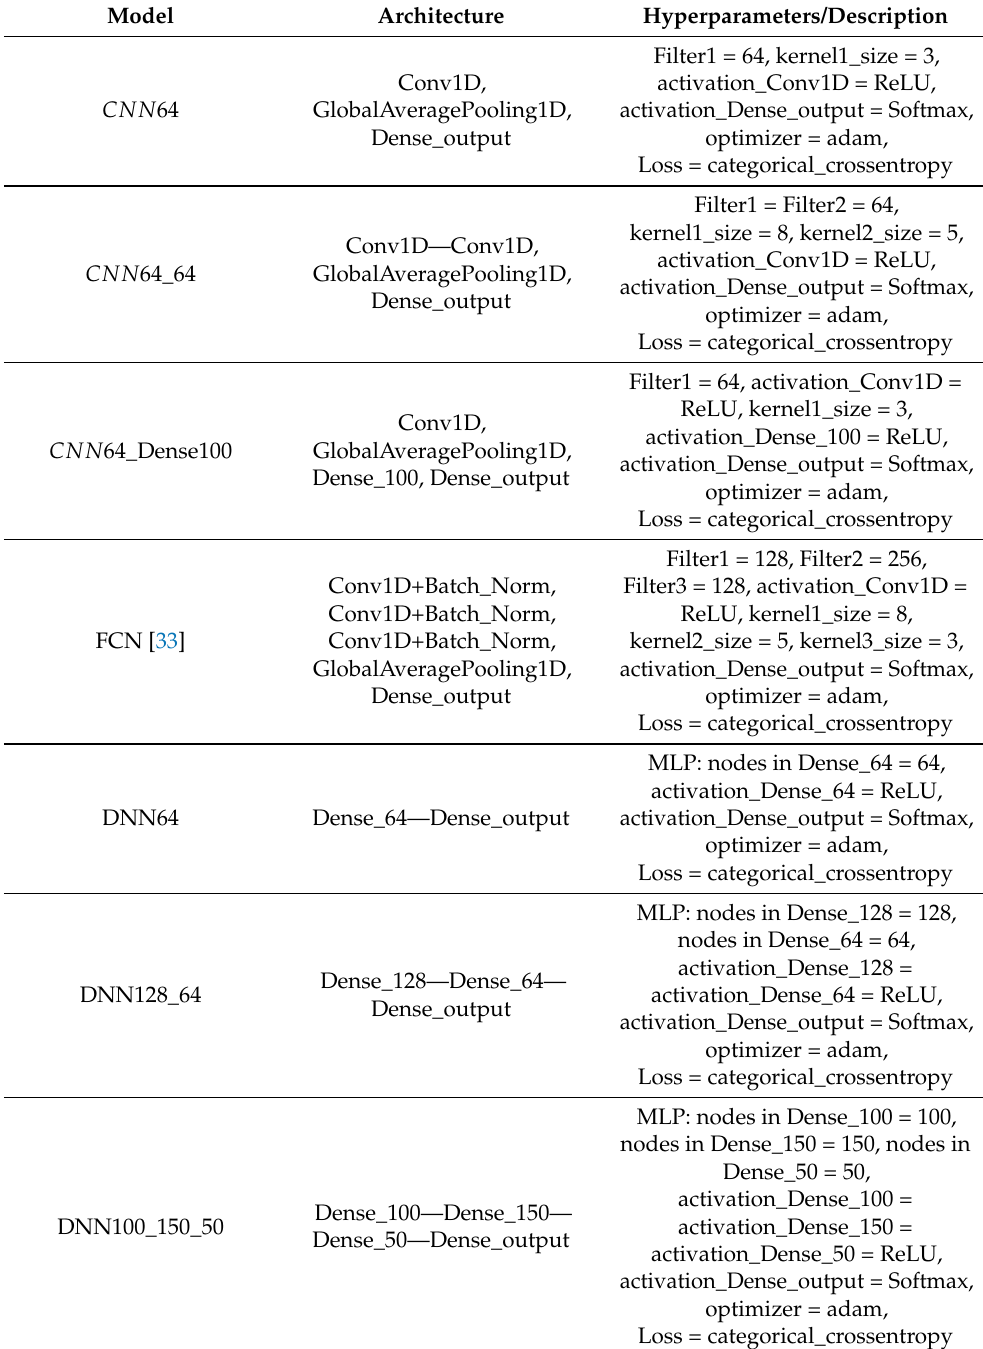
Table 1. The different DNN models employed and their